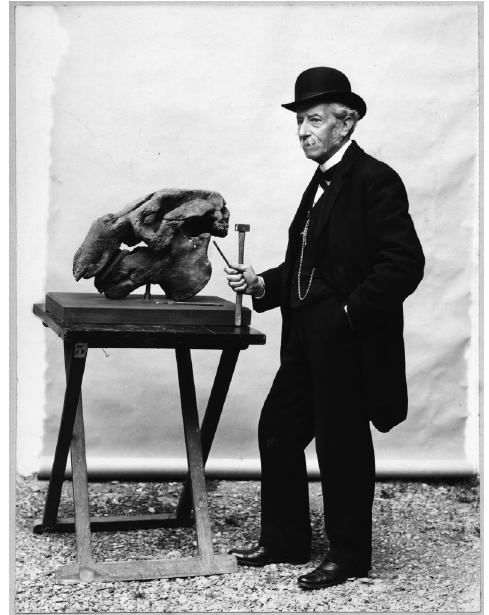
Fig. 1. Giovanni Capellini at work in the museum (Archives of the Capellini Museum. We wish to thank the Curator of the Museum, Prof. Gian Battista Vai, for having made this photograph available to